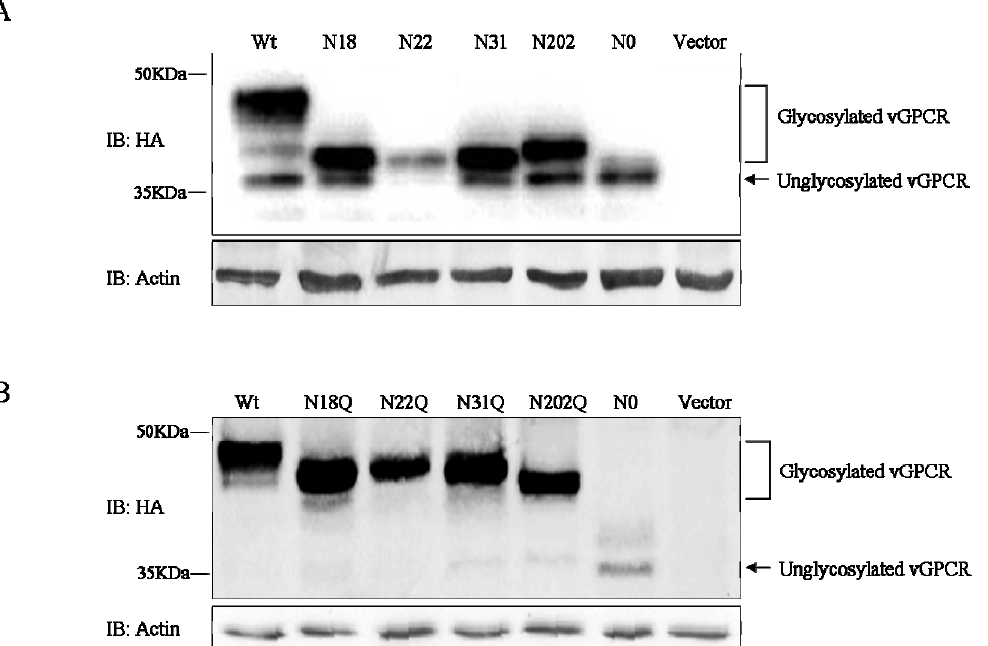
Figure 2. There exist four sites of N-linked glycosylation in vGPCR. ( A ) HEK293T cells were transfected with FRT-TO-HA-vGPCR, un-glycosylated vGPCR mutant N0 or vGPCR mutants with single site of glycosylation (N18, N22, N31 and N202) separately. Transfected cells were harvested at 48 h post-transfection and lysed, whole cell lysates were examined by immunoblot analysis. ( B ) HEK293T cells were transfected with FRT-TO-HA-vGPCR, un-glycosylated vGPCR N0 or vGPCR mutants with three sites of glycosylation (N18Q, N22Q, N31Q and N202Q) separately. Transfected cells were harvested at 48 h post-transfection and lysed, whole cell lysates were examined by immunoblot analysis. Wt: FRT-TO-HA-vGPCR; Vector: FRT-TO empty vector; N18, N22, N31, N202, N18Q, N22Q, N31Q, N22Q, N202Q, N0: FRT-TO plasmids expressing corresponding vGPCR mutants with HA